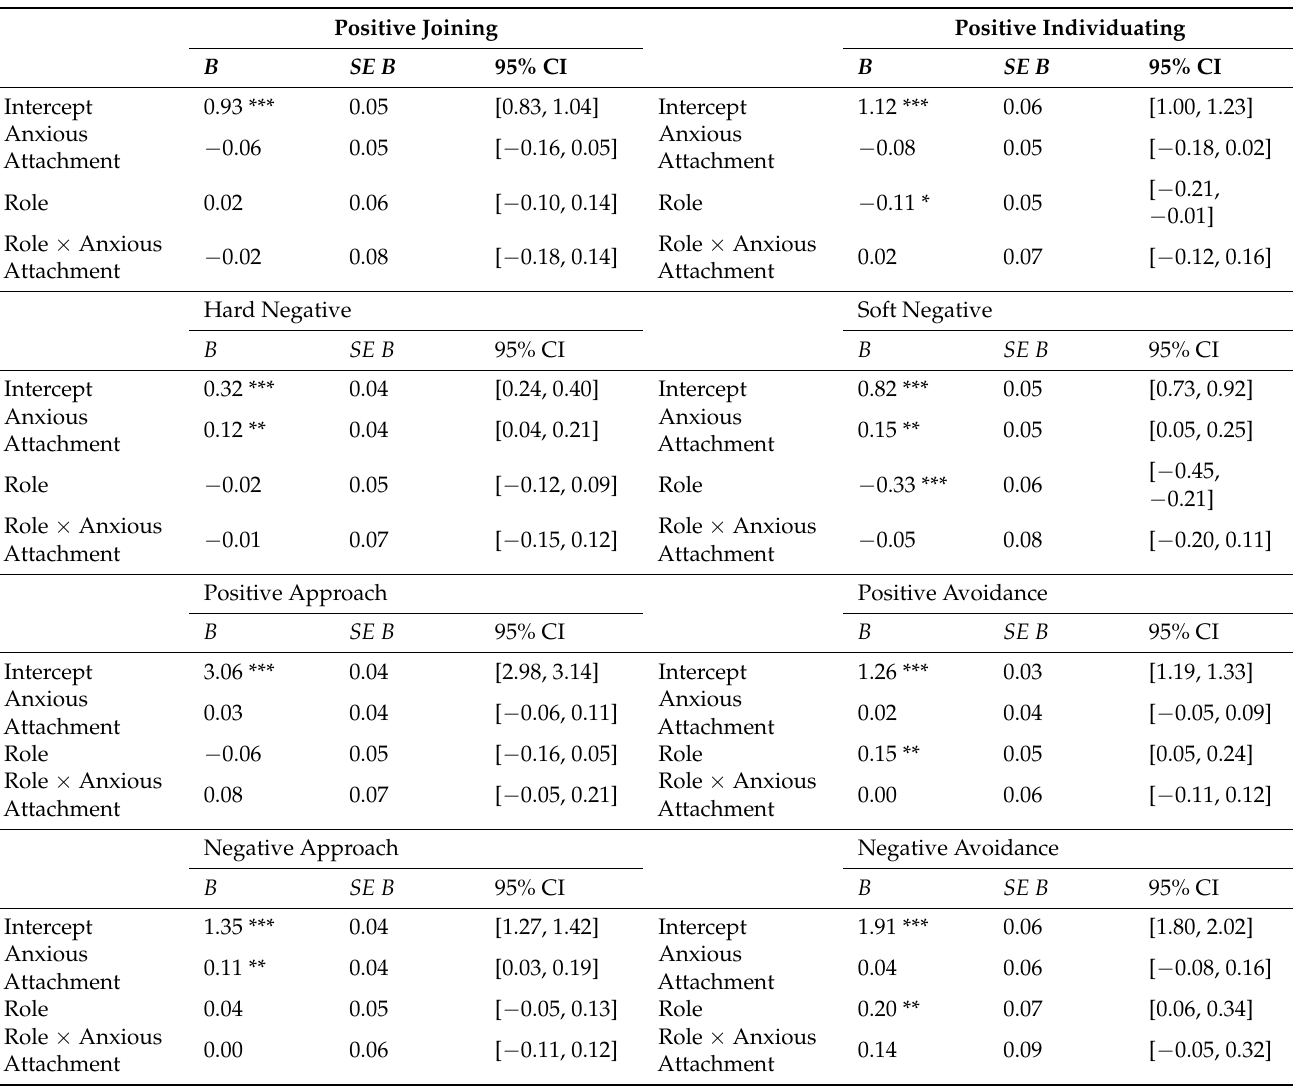
Table 3. Two-level mixed effect models of anxious attachment, affective expression, and communica- tion behavior for patients and